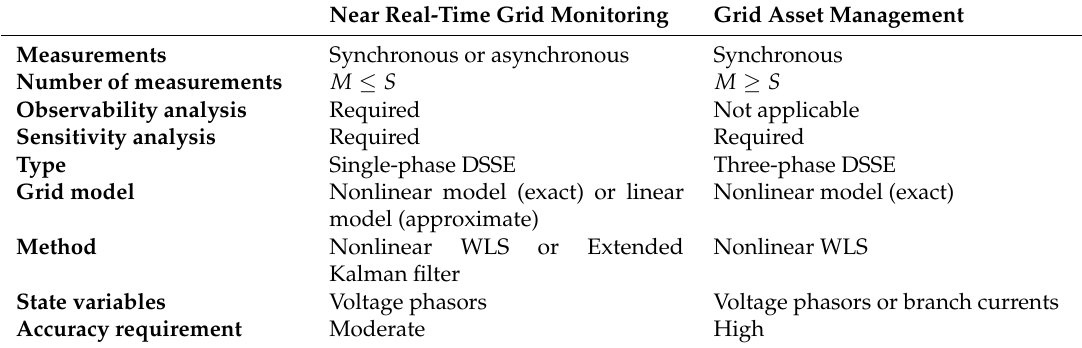
Table 1. Comparison of requirements of DSSE algorithm.